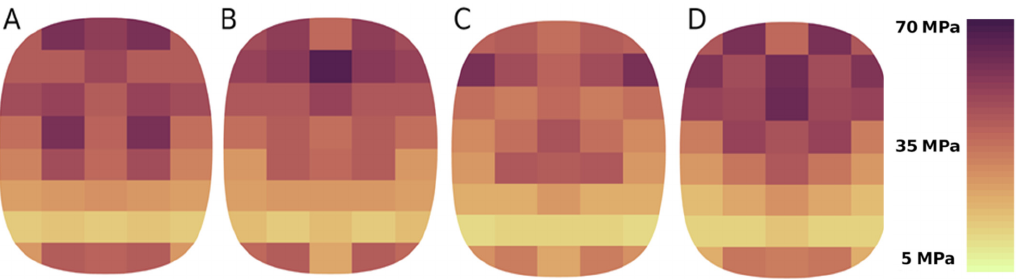
Figure 12. Stress distribution on the forming groove surface during briquetting of a mixture based on copper ore concentrate for circumferential speeds of rollers: ( A )—0.1 m/s; ( B )—0.15 m/s; ( C )—0.2 m/s; ( D )—0.3 m/s.